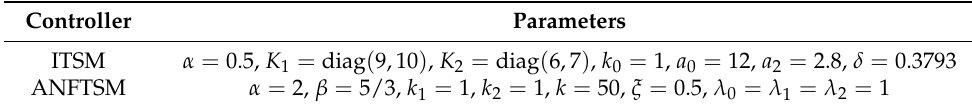
Table 2. Controller parameters of ITSM and